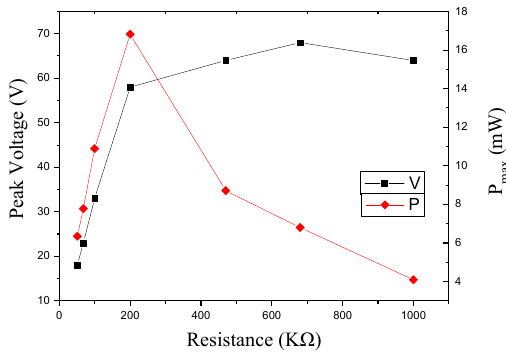
Figure 13. Peak voltage and output power under an open circuit.